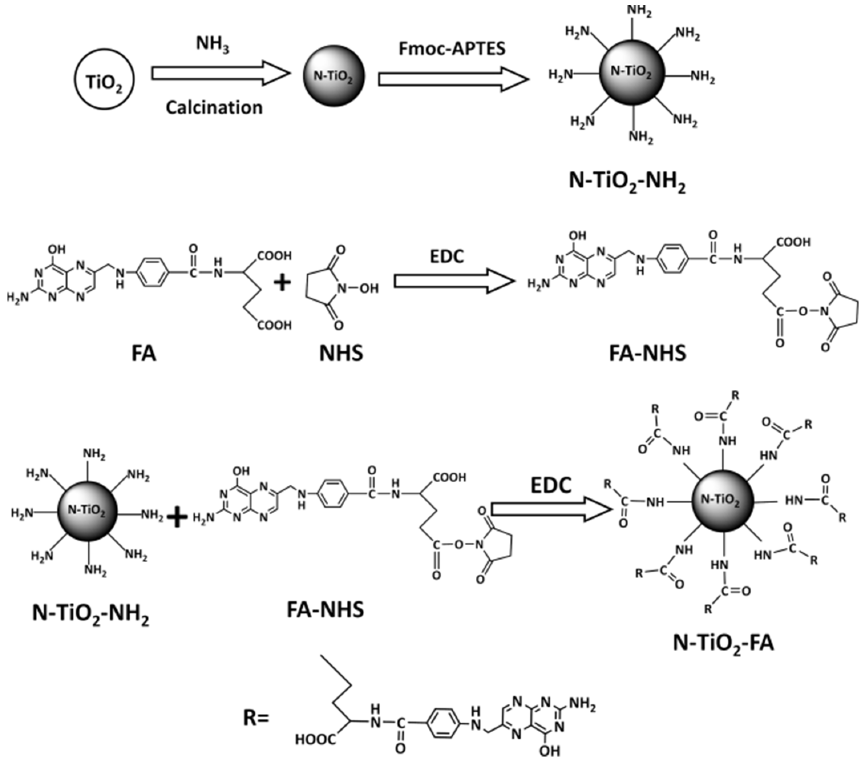
Figure 1. Synthesis procedure of N-TiO 2 -folic acid (FA) nanoparticles (NPs).